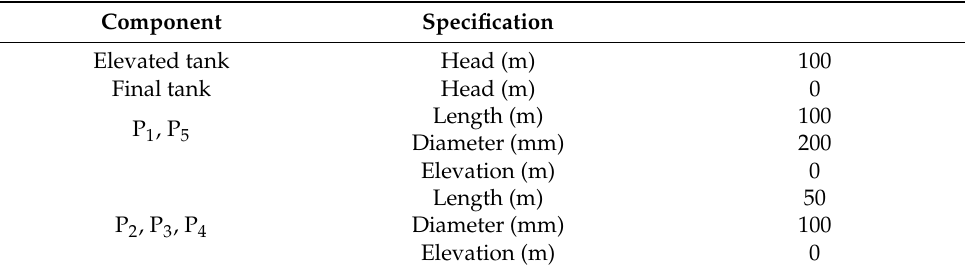
Figure 1. Simple network structure. Table 3. Simple synthetic network characteristics.